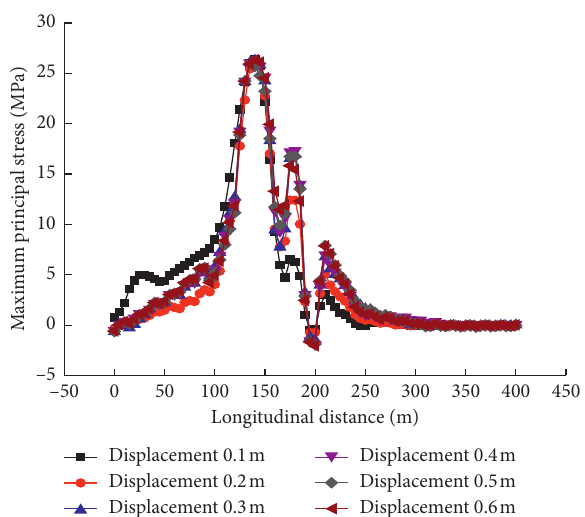
Figure 5: Maximum principal stress distribution curve of the lining with different displacements under coupling fault